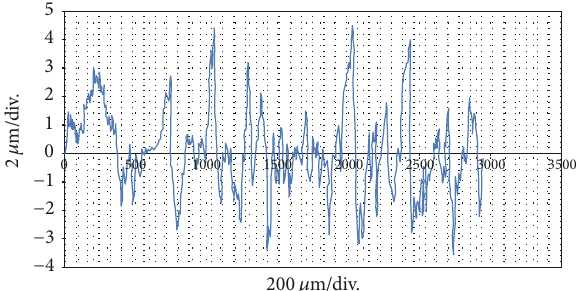
Figure 8: Profile of surface roughness graph by surface roughness tester for machined surface with speed 500 rpm, depth of cut 0.5 mm, and feed rate 150 mm/min.